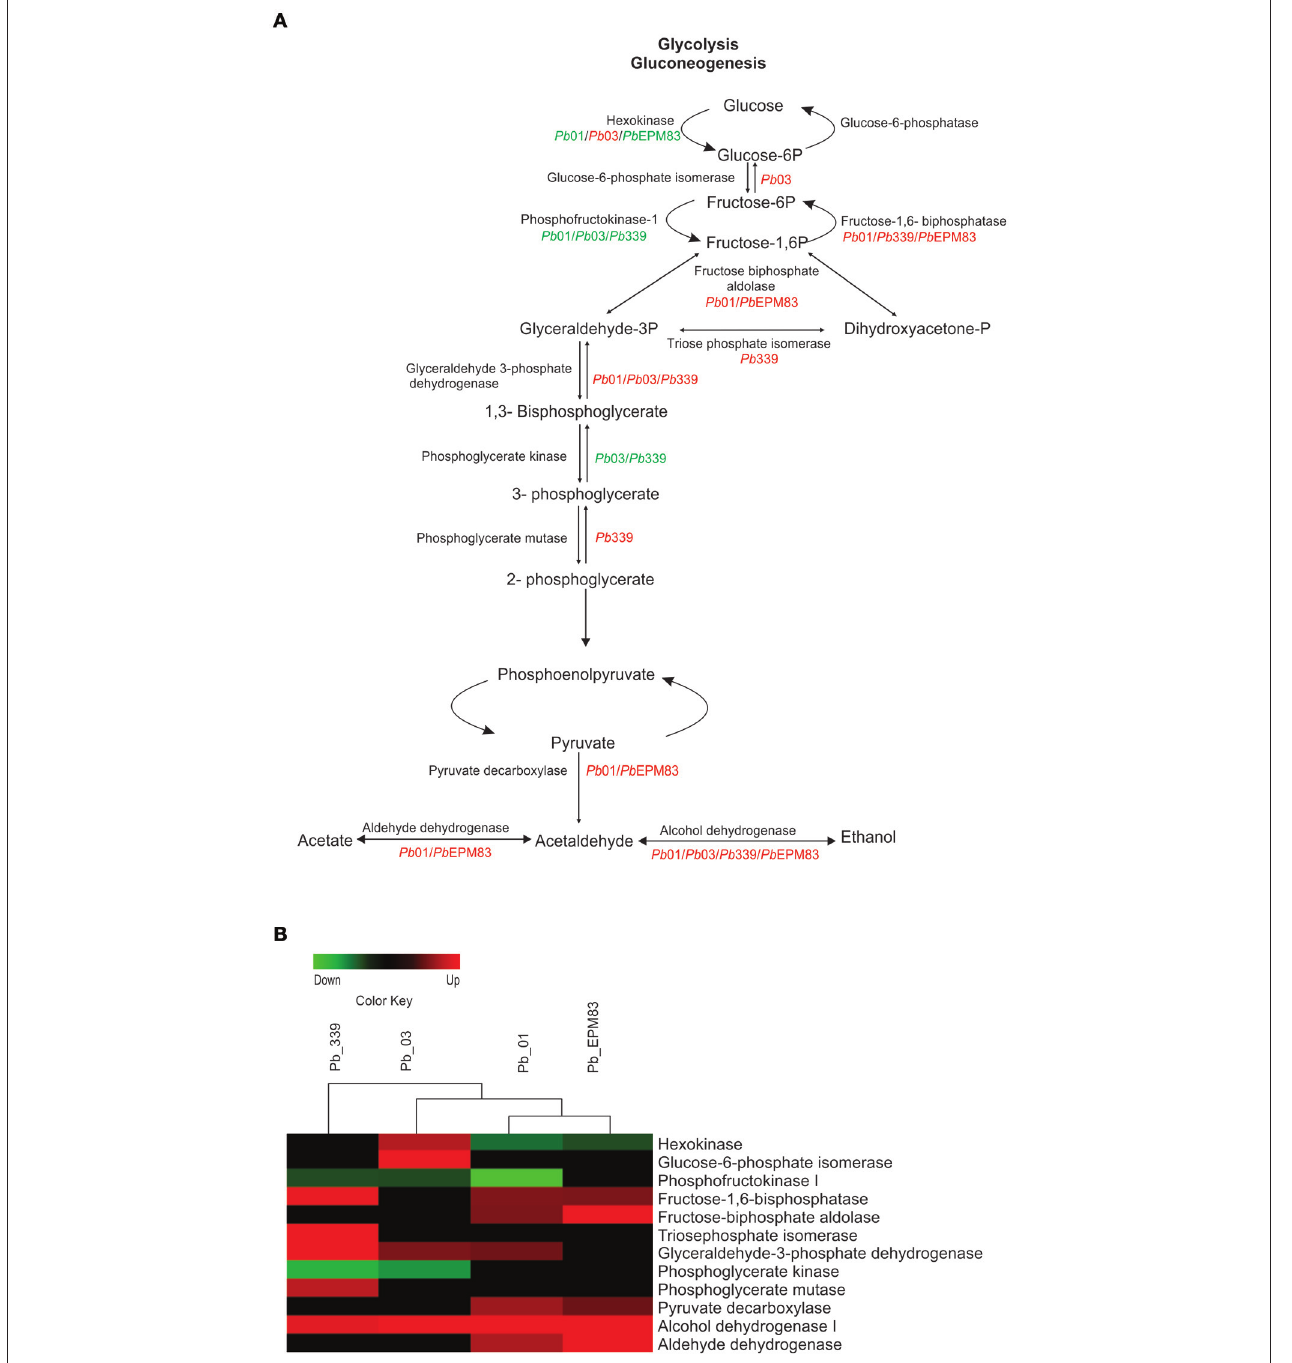
FIGURE 2 | Comparison of protein profiles related to glycolysis and gluconeogenesis in P. lutzii and isolates of P. brasiliensis . ANOVA was applied to compare expression values among isolates, applying a cut-off of 1.5-fold. Expression data were obtained using the Multi Experiment Viewer software V.4.8, which was used to group and compare expression data. (A) Representative diagram of the glycolysis/gluconeogenesis and fermentation pathways depicting down-regulated (green) and up-regulated (red) proteins in the isolates, as cited above. (B) Changes in expression levels in yeast cells incubated with acetate in the four analyzed isolates are represented in a heat map format. Mean values of experimental triplicates are shown for down-regulation (green) and up-regulation (red) of genes of isolates Pb 01, Pb 03, Pb 339, and Pb EPM83 in the presence of sodium acetate. Black indicates that no significant difference was observed.